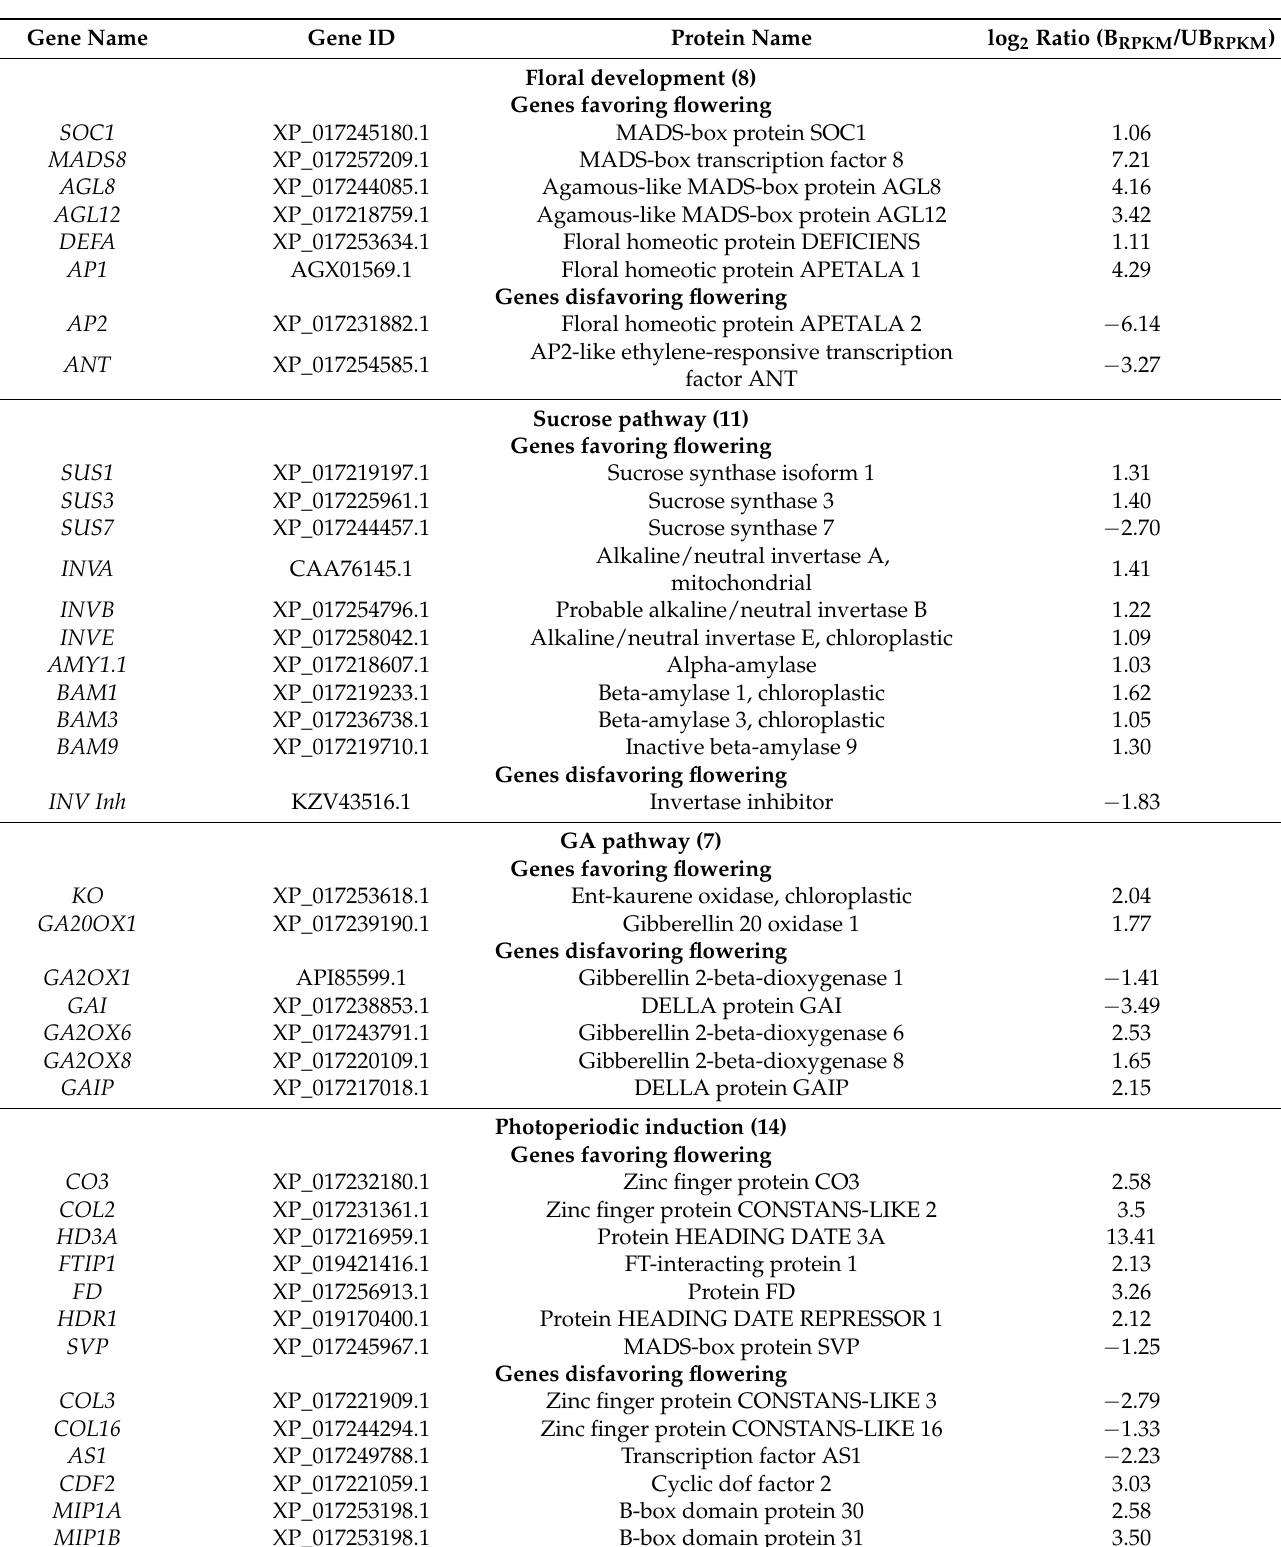
Table 3. Bolting/flowering genes differentially expressed in bolted and unbolted A. sinensis